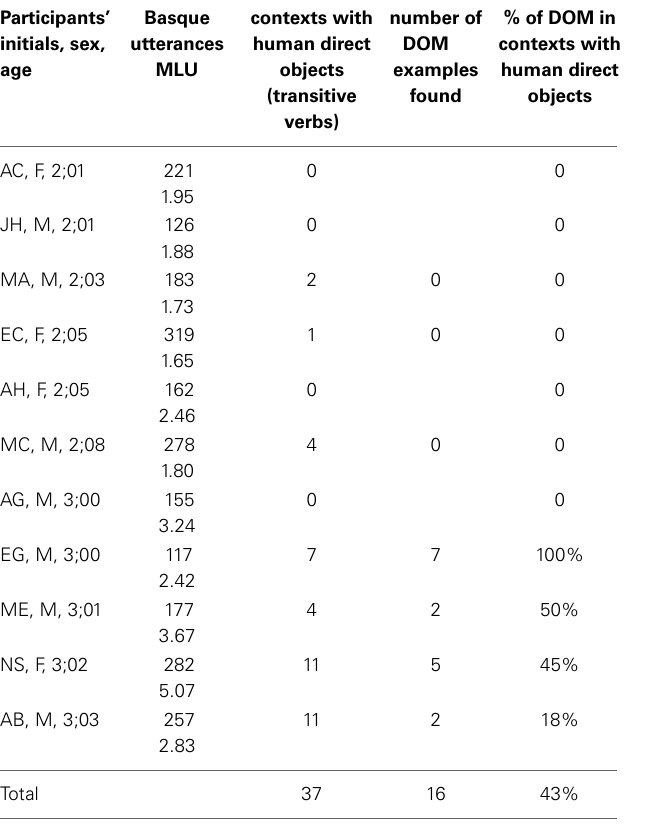
Table 10 | Use of DOM in Basque by monolingual children.